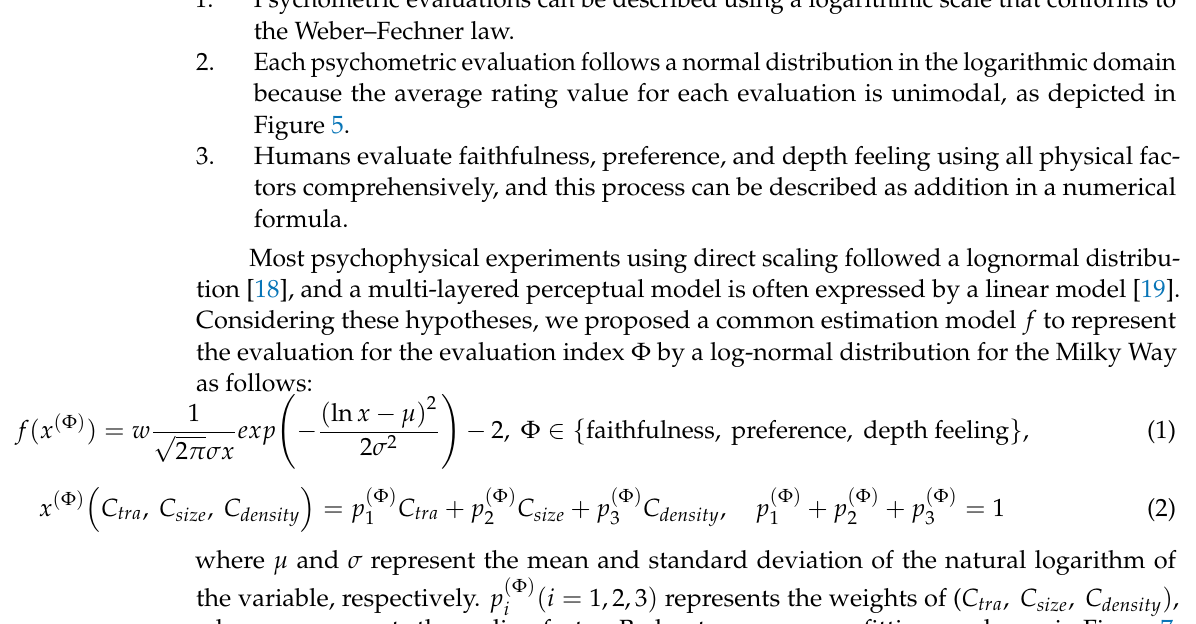
Figure 6. Component of each projection pattern.